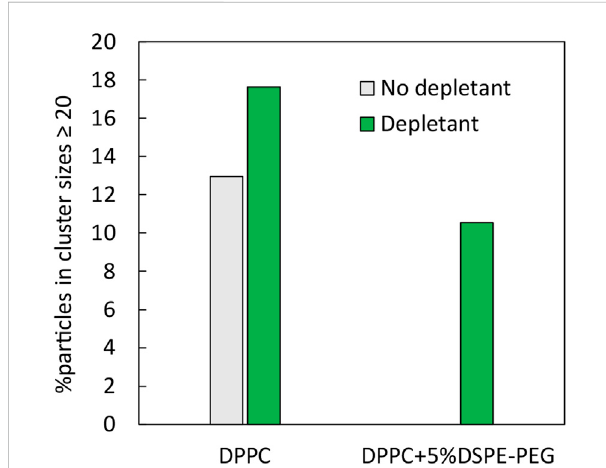
FIGURE 6 The percentageofparticlesin cluster sizes ≥ 20 CSLBs/cluster for DPPCCSLBsandDPPC+5%DSPE-PEG 2000 CSLBsathighareafraction φ = 0.11 with and without 100 kDa PEG depletant (0.05 c *). Note — without depletant, 0% of DPPC+5%DSPE-PEG 2000 CSLBs are present in large clusters of ≥ 20 CSLBs per